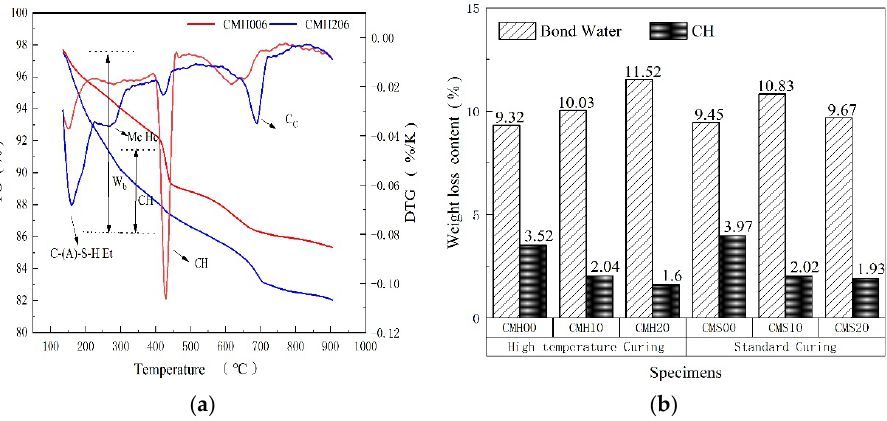
Figure 8. ( a ) Thermogravimetric analyses curve (TG and DTG) and ( b ) hydration products